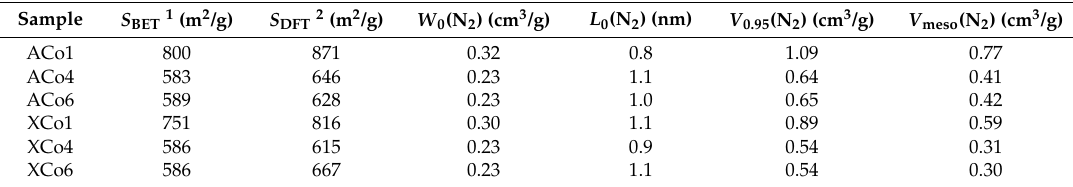
Table 1. Name, surface areas, and pore volumes of the doped carbon gels.